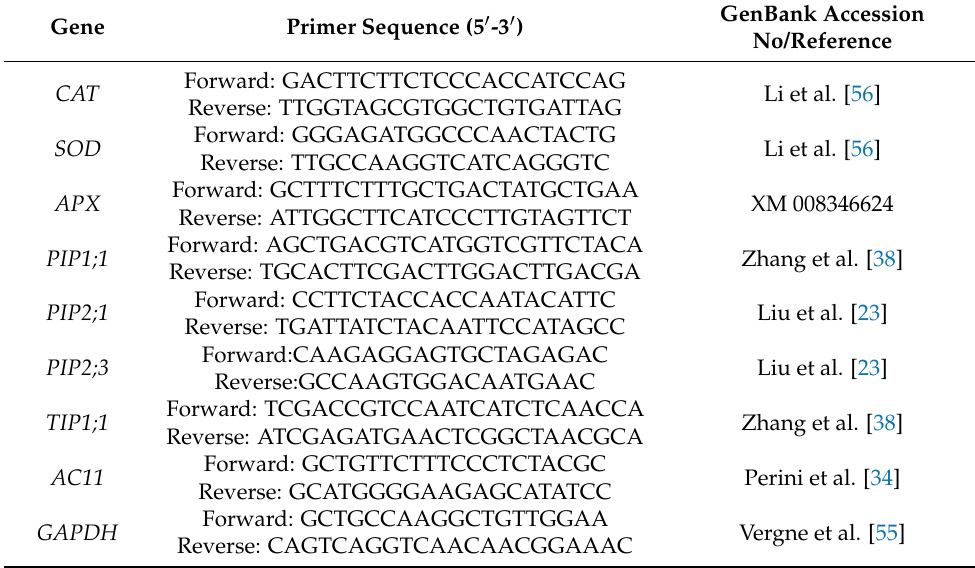
Table 1. Primer sequences used for qRT-PCR